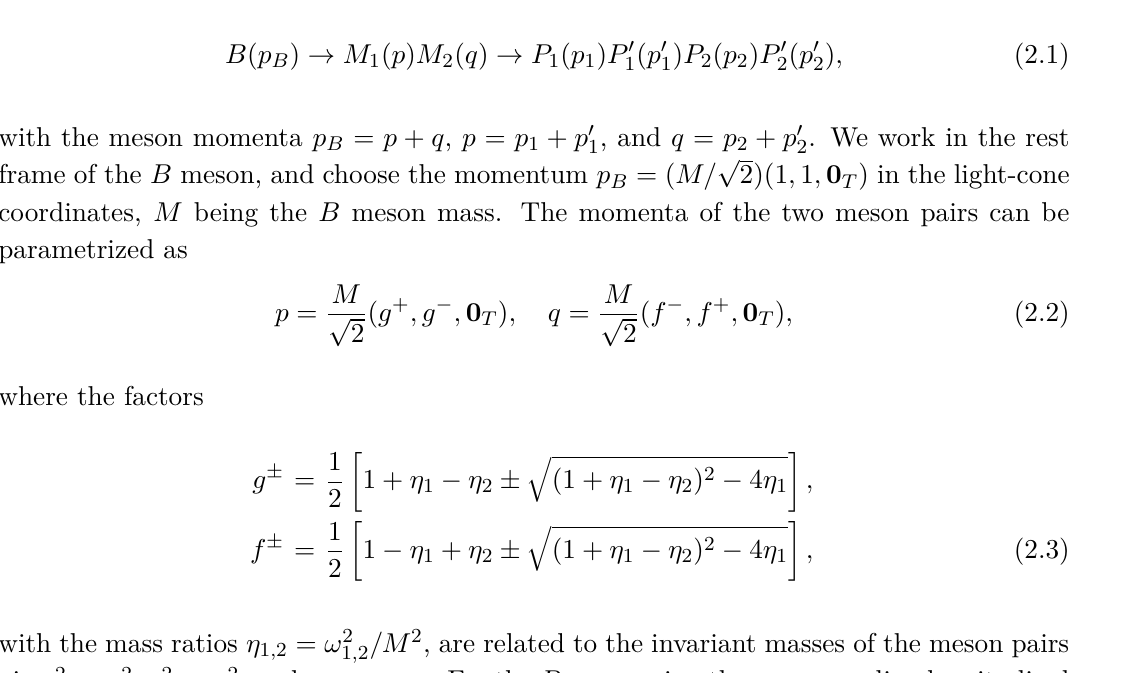
and M 2 → P 2 P 0 1 2